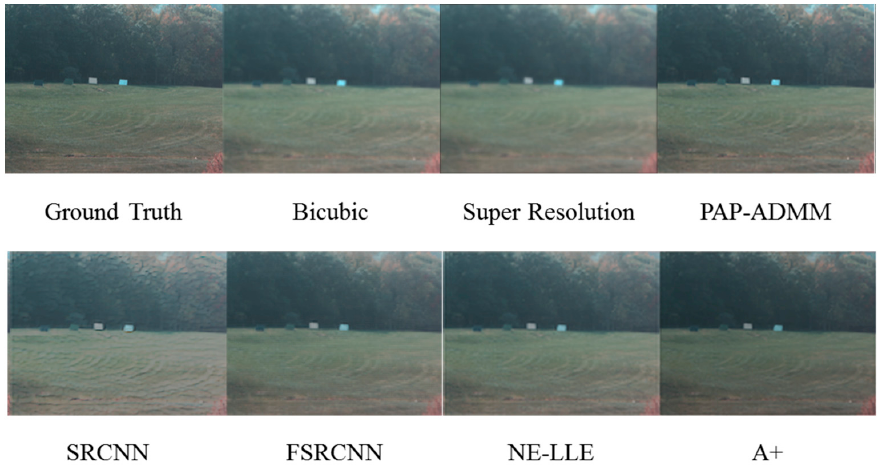
Figure 2. Comparison of seven single image super-resolution algorithms using the AF hyperspectral image in the visible range.